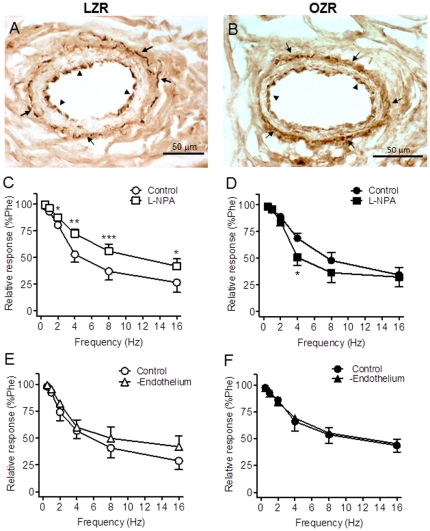
NO derived from nNOS contributes to the nerve-mediated relaxations in penile arteries from LZR but not OZR.
A, B. Immunohistochemical demonstration of the presence of nNOS in perivascular nerve fibers: in the adventitia (arrows), and in the endothelial cell layer (arrow head) of the penile arteries from LZR and OZR. Note that localization of nNOS immunoreaction was similar in LZR and OZR. C, D. Selective inhibition of nNOS with NW-propyl-L-arginine hydrochloride (L-NPA, 3×10−6 M) reduced the EFS frequency- dependent relaxations in penile arteries from LZR but not OZR.. E, F. EFS frequency- dependent relaxations were unaltered in endothelium-denuded penile arteries from LZR and OZR. Results are mean ± SEM of 5–7 arteries. *P<0.05, **P<0.01, ***P<0.001 vs control.